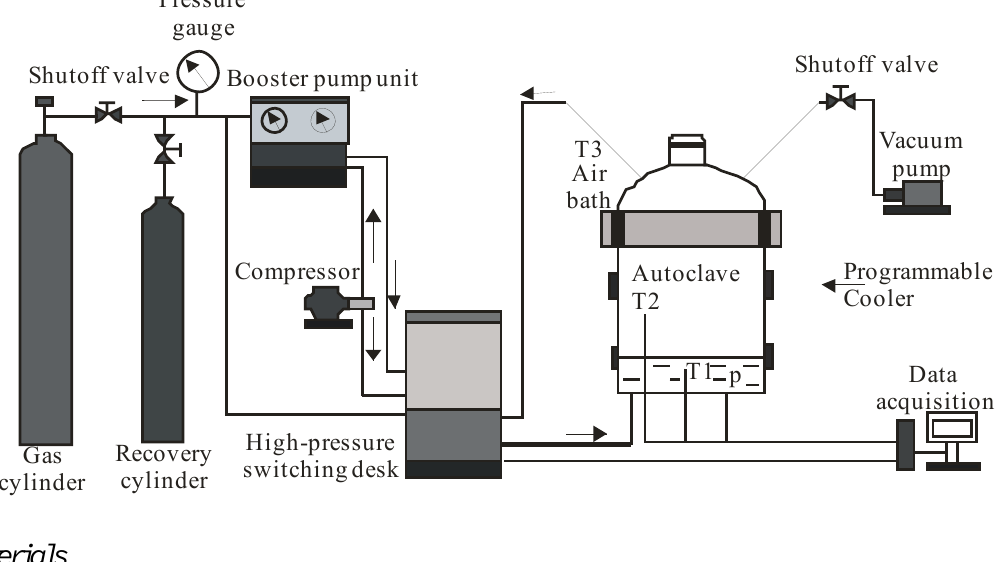
Figure 1. Schematic diagram of the experimental gas-hydrate integrated simulation